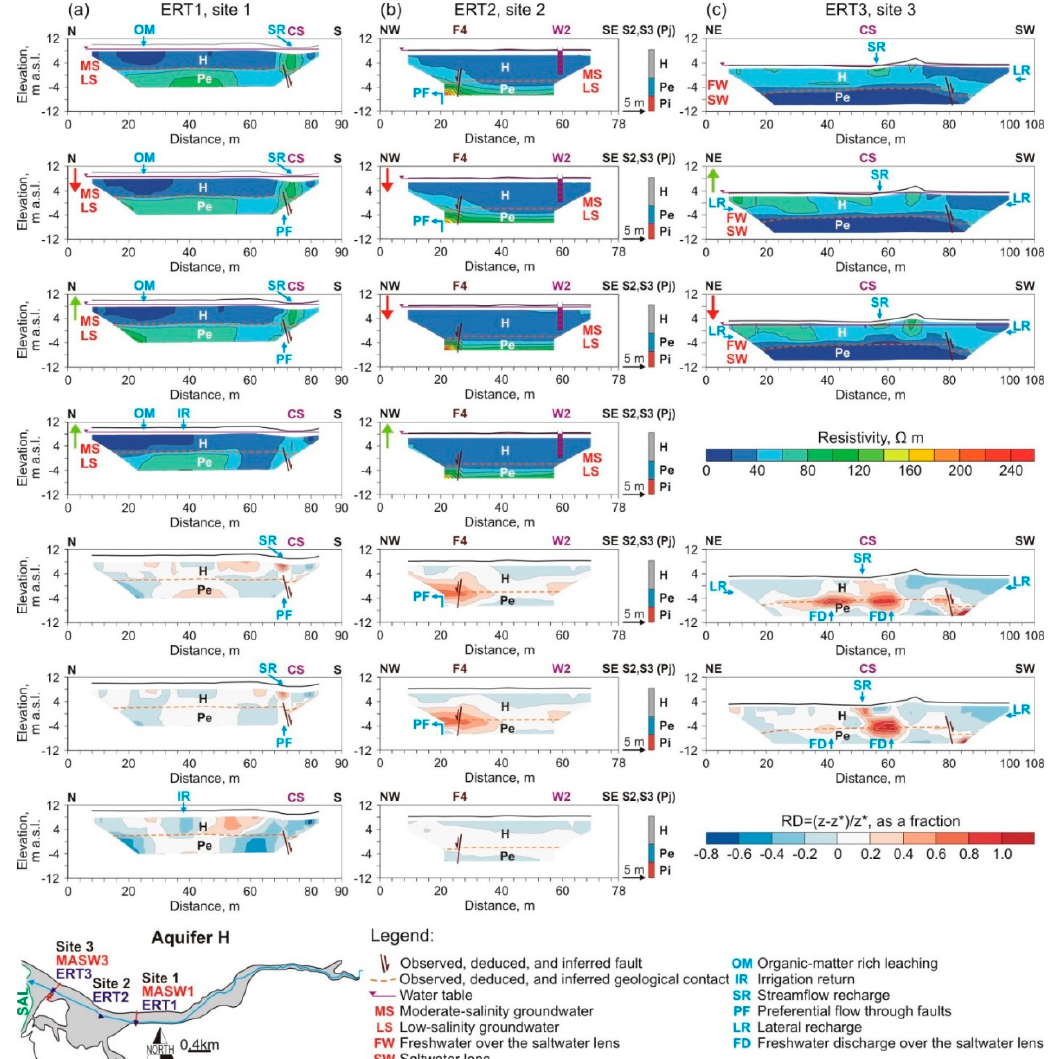
Figure 6. At sites 1 ( a ), 2 ( b ), and 3 ( c ), time-lapse ERT1, ERT2, and ERT3 surveys in March, June, September, and December 2014 (rows 1 to 4), and relative difference, RD = (z–z*)/z*, of nodal ER data from March, June, and December lapses (z) regarding nodal ER data from the September lapse (z*) (rows 5 to 7). The projected (Pj) logs of geotechnical soundings S2 and S3 after [40], and water table recorded in each lapse in sites 1 (well W4), 2 (well W2), and 3 (well W1) as in Figure 4 are shown; in the top left-hand corner of plots, green and red vertical arrows show, respectively, water-table raise and depletion relative to previous lapse. Preliminary geological and hydrogeological interpretations of ER models after integration of geological findings from VS models (Figure 5) and aquifer conceptualization (Figure 2) are included; red acronyms denotes groundwater types, and blue arrows and acronyms denote natural processes and human-induced actions determining transient water transferences and fluxes. Profiles are topographically corrected and its vertical-to-horizontal scale ratio is 1:1. CS, Cascalheira Stream; H, Holocene; Pe, Pleistocene; and F8, NE–SW strike-slip fault.